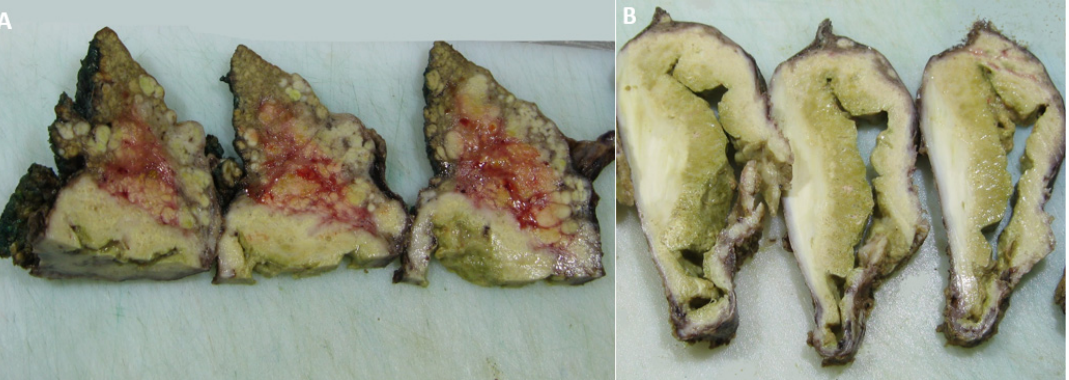
Figure 4. The macroscopic specimen shows a cross-section of the tumor tissue corresponding to the malignant alteration of the liver parenchyma ( A ) and the parasitic cyst next to the tumor ( B ).